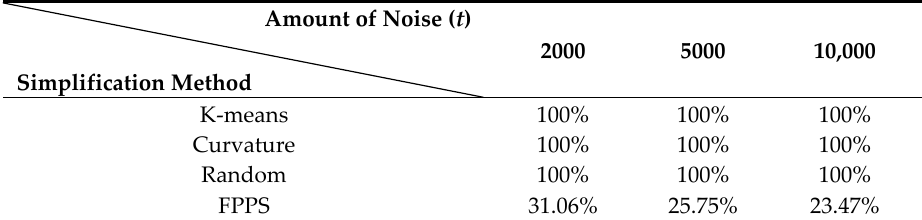
Table 5. The noise simplification ratio r using the different simplification algorithms.